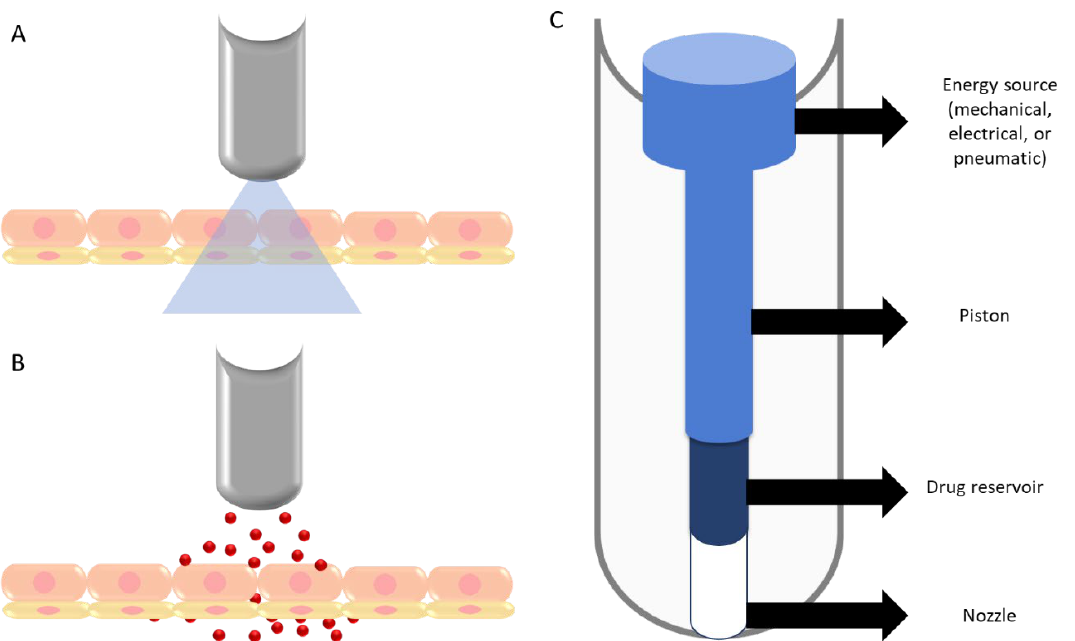
Figure 7. Graphical representations of ( A ) a liquid jet injector and ( B ) a powder Injector. ( C ) The internal anatomy of such devices. Figure Reprinted with permission from [278].